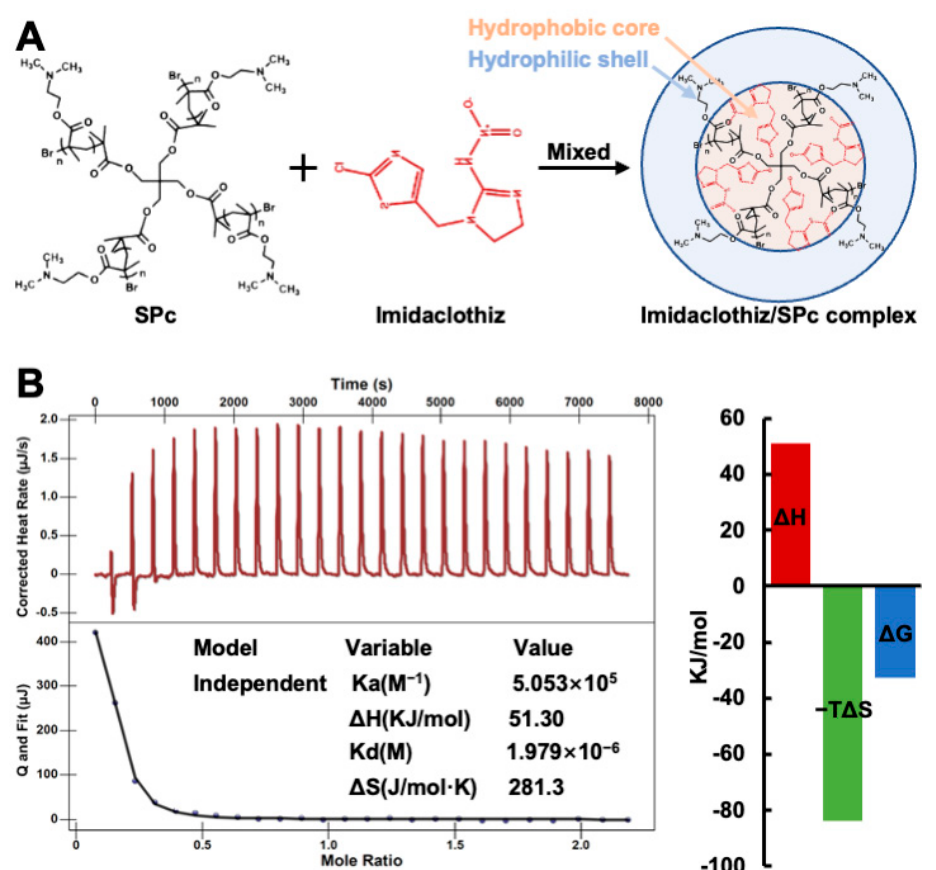
Figure 1. Schematic illustration of imidaclothiz/SPc complex ( A ) and ITC titration of SPc into imidaclothiz solution ( B ). The 2 mL of pure imidaclothiz solution (0.138 mmol/L) was titrated with 250 μ L of SPc solution (1 mmol/L), and the test temperature was 25 °C.